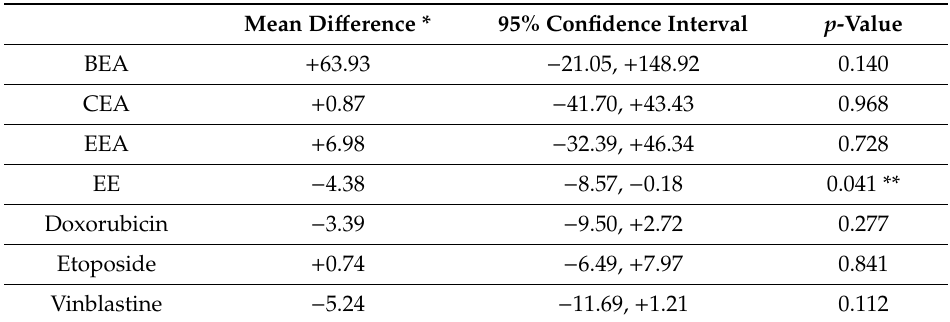
Table 9. Mean di ff erence of IC 50 compared to cancer samples and normal samples, 95% confidence interval and p